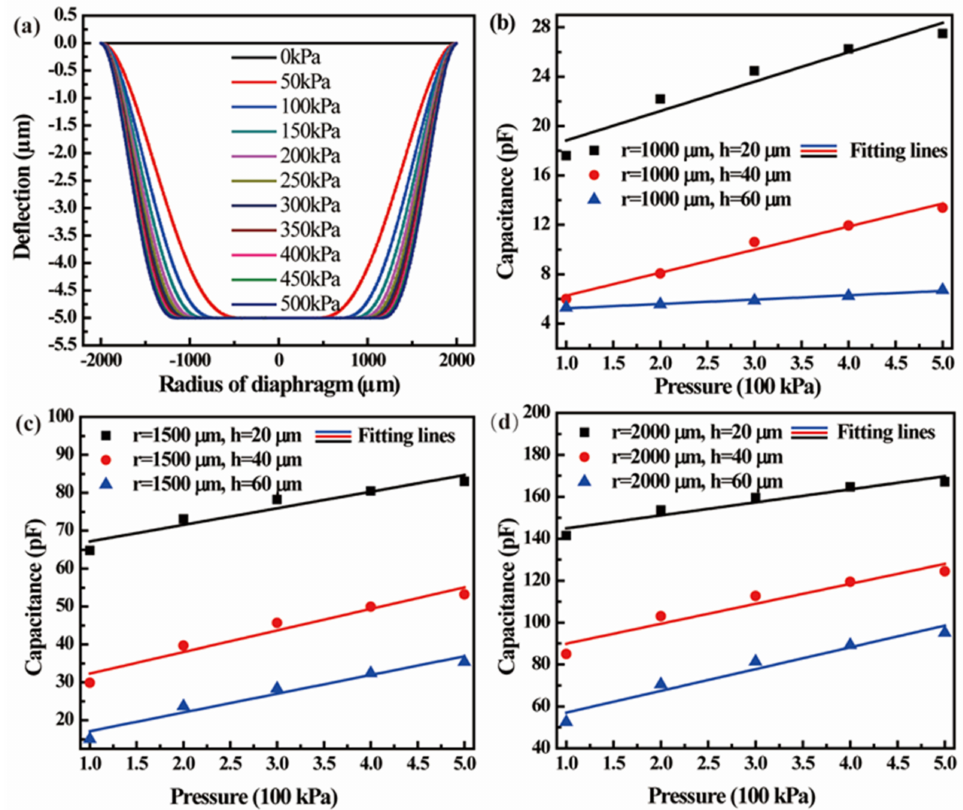
Figure 3. ( a ) Effect of pressure on deflection of diaphragm with radius of 2000 µ m and thickness of 40 µ m; C-P characteristics of CPSs with diaphragm radius of ( b ) 1000, ( c ) 1500, and ( d ) 2000 µ m in different diaphragm